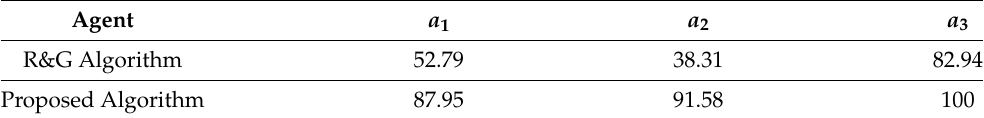
Table 1. Goal prediction accuracy (%).